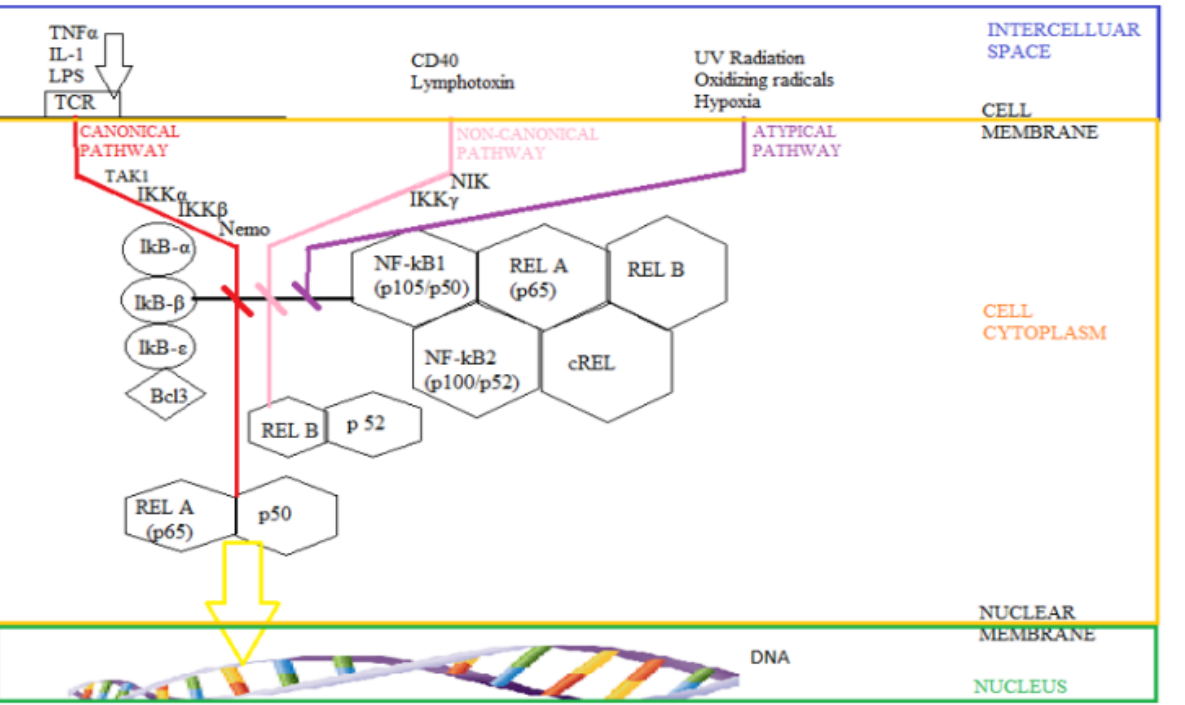
Figure 3. The cellular mechanism of hypoxia (showing how oxygen partial pressure, pO2, influences deoxynucleic acid, DNA, via hypoxia-inducible factor, HIF; with involvement of factor inhibiting HIF, FIH; arginine, ARG; C-terminal transactivation domain, CAD; protein 300, p300 and Von Hip- ple-Lindau factor, VHL and proline hydroxylase, PHD. We can see how hypoxia response elements (HRE) are activated, as the atypical Nuclear Factor kB, NF -kB, activation pathway, with involve- ment of inhibitor kB, I-kb. This triggers the genes of lactate dehydrogenase A, LDH-A; adenylate kinase 3, AK-3; aldolase A, ALD-A; phosphoglycerate kinase 1, PGK-1; phosphofructokinase, liver type, PFK-L 6; vascular endothelial growth factor, VEGF; erythropoietin, EPO; glucose transporter 1, Glut-1; interleukin 8, IL 8; B cell lymphoma-2, Bcl-2; matrix metalloproteases, MMP; stromal cell- derived factor 1, SDF).